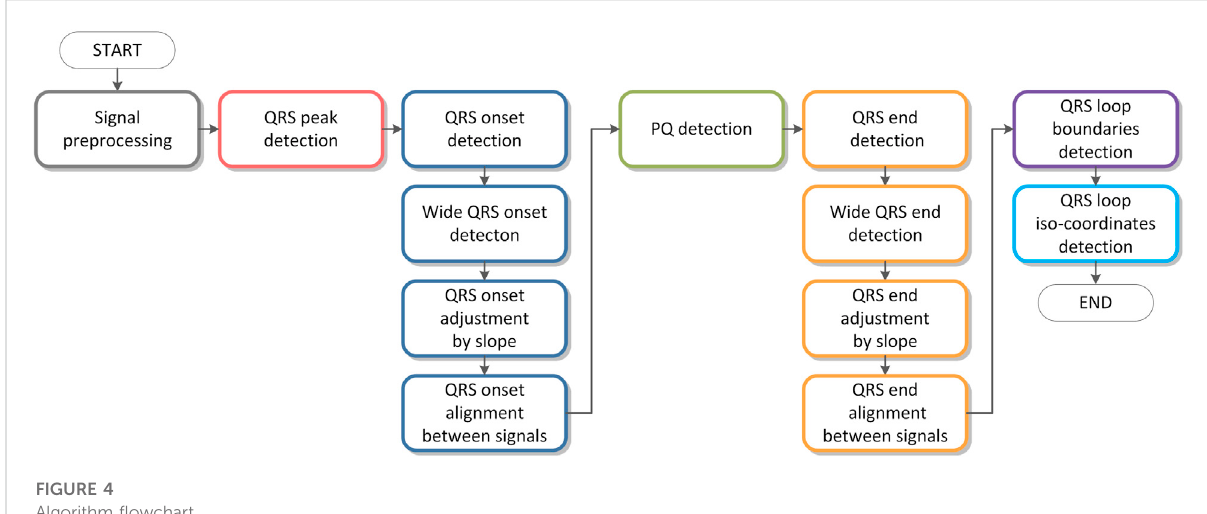
FIGURE 4 Algorithm fl